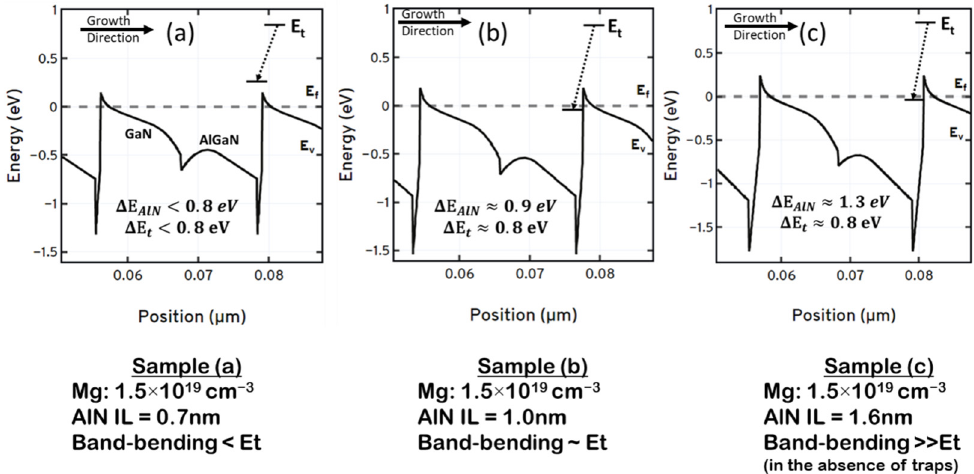
Figure 7. Actual simulated valence band diagram using the Silvaco package, accounting for acceptor-like traps at positive polarization interfaces for samples ( a – c ) with Mg doping of 1.5 × 10 19 cm − 3 and AlN layer thickness of 0 nm, 1 nm, and 1.6 nm, respectively. In sample A, both band-bendings, Δ E (AlN) and Δ E (GaN) , are less than 0.8 eV. In sample B, Δ E (GaN) is less than 0.8 eV, but Δ E (AlN) is ~0.9 eV, and so the acceptor-like trap ionizes. In ( c ), Δ E (AlN) is ~1.3 eV (from STR-FETIS), and so the acceptor-like trap ionizes. This shows that the trap hypothesis mentioned in this paper holds. The trap level, E t, is also indicated in the figure.